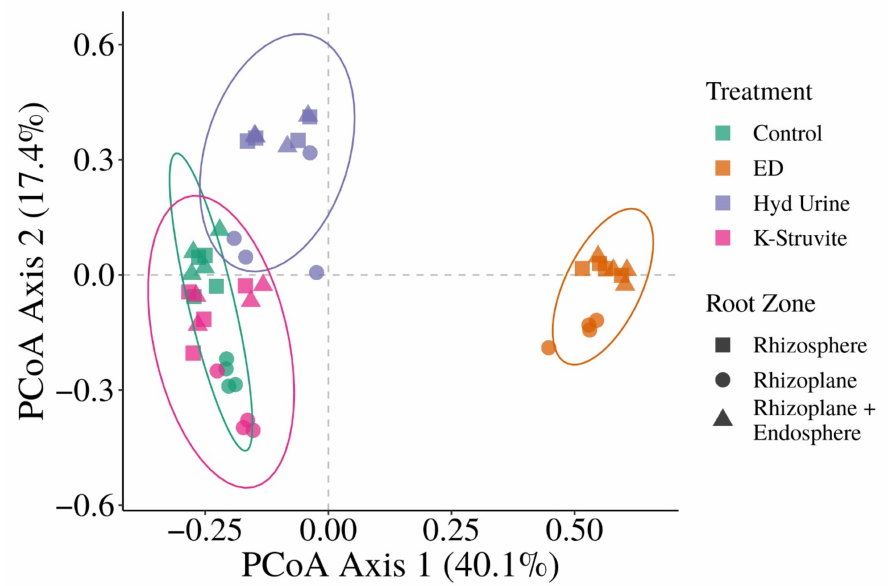
Figure 2. Bray-Curtis dissimilarity Principle Coordinates Analysis (PCoA) of the lettuce root- associated bacterial community samples. Colors indicate the urine-derived fertilizer treatment (ED: electrodialysis concentrate, Hyd Urine: hydrolyzed urine), and symbols indicate the root zone of the samples (4 replicates). Ellipses are drawn using a multivariate